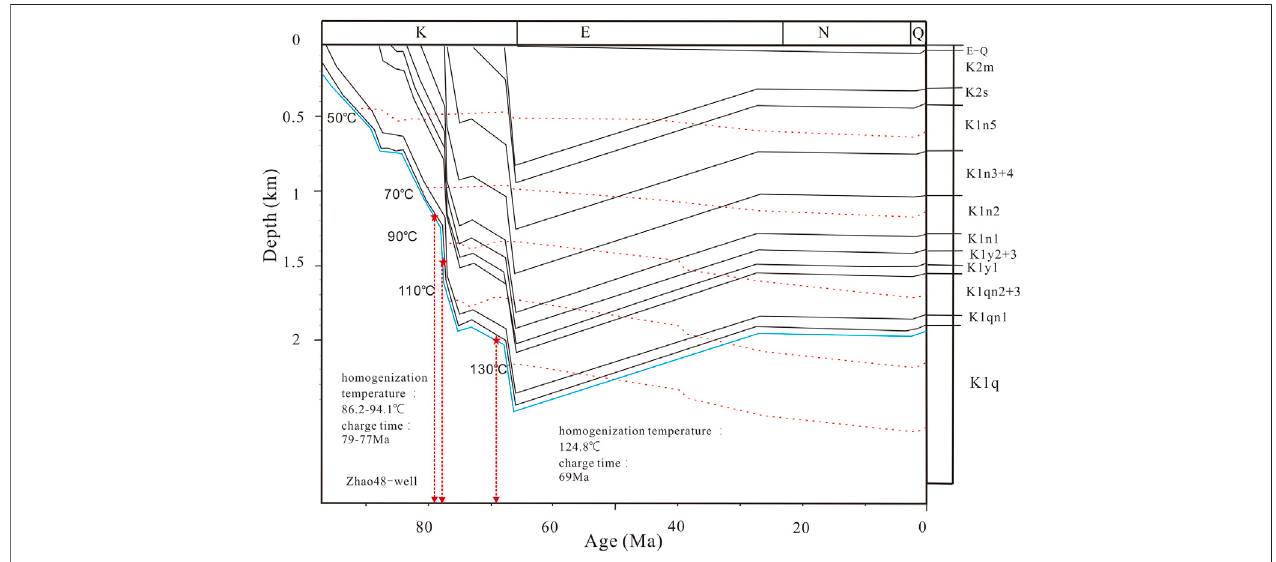
FIGURE 7 | Charging stages of hydrocarbon in the Fuyu oil reservoir of the Sanzhao area.